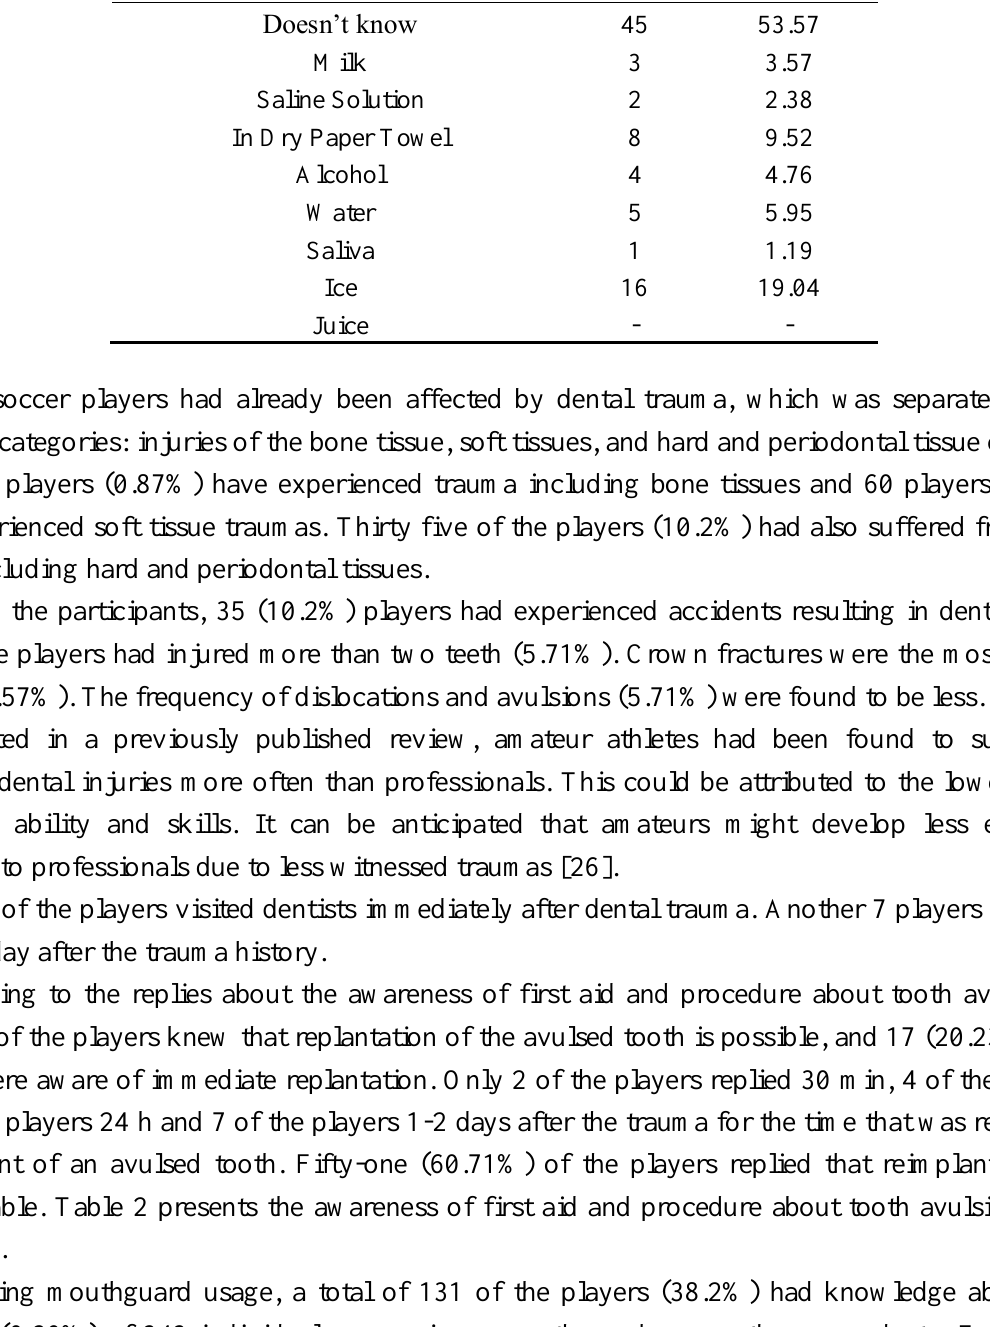
Table 2. The awareness of first aid and procedure about tooth avulsion-storing conditions. Tooth Avulsion-Storing